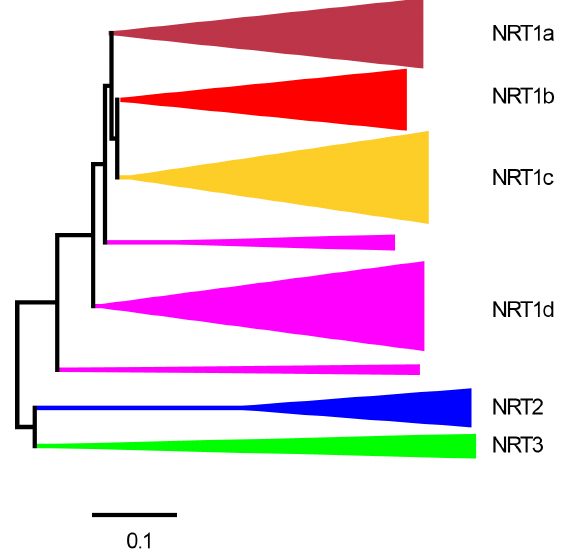
Figure 1. Overview on the phylogeny of the NRT families in P. trichocarpa and A. thaliana . Detailed information of each clade is presented in figure 2. ClustalX2 was used to perform the alignment of the amino acids and to calculate the final tree with the neighbor-joining method and a bootstrap value of n=1,000. The tree was displayed using MEGA